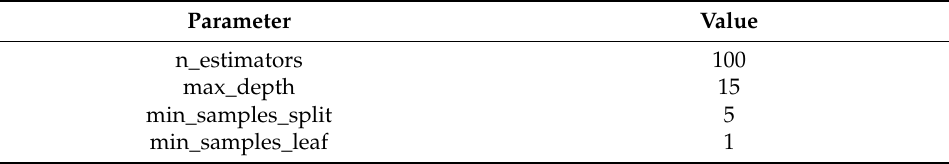
Table 5 below presents the parameter values set used in the RF. Table 5. Optimized parameter values for the Random Forest model.